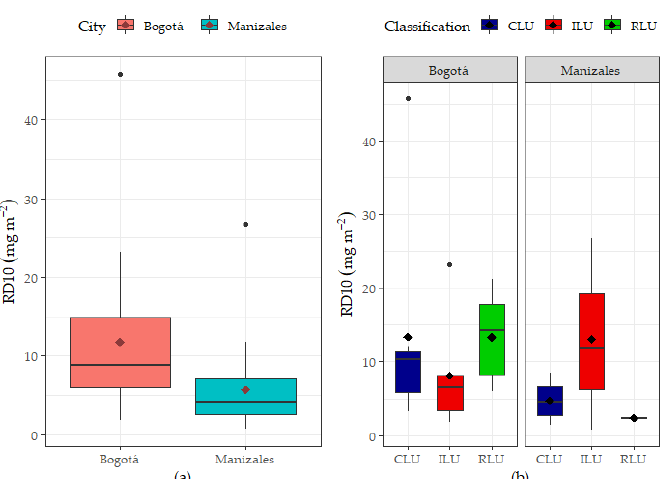
Figure 2. Road dust loads boxplots ( a ) for Bogotá and Manizales and ( b ) grouped by land use for Bogotá and Manizales—CLU: commercial land use; ILU—industrial land use; RLU—residential land use.